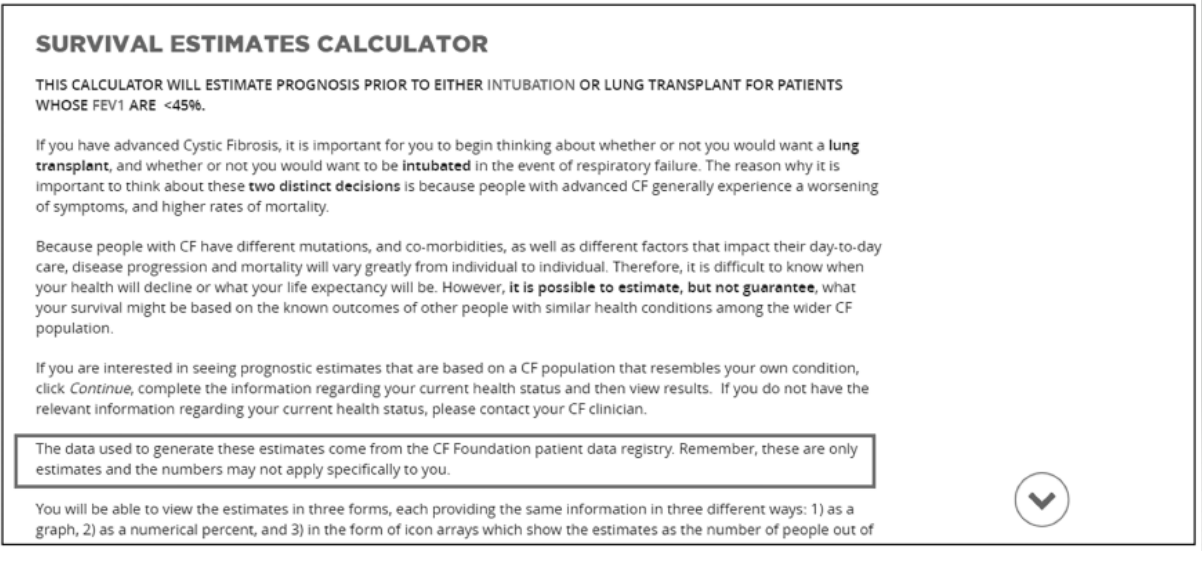
Figure 4. Survival estimates calculator page as seen by study participants. The statement that the percentages generated by the survival estimates calculator are only estimates and do not necessarily apply to individual patients has now been bolded for emphasis. CF: cystic fibrosis.